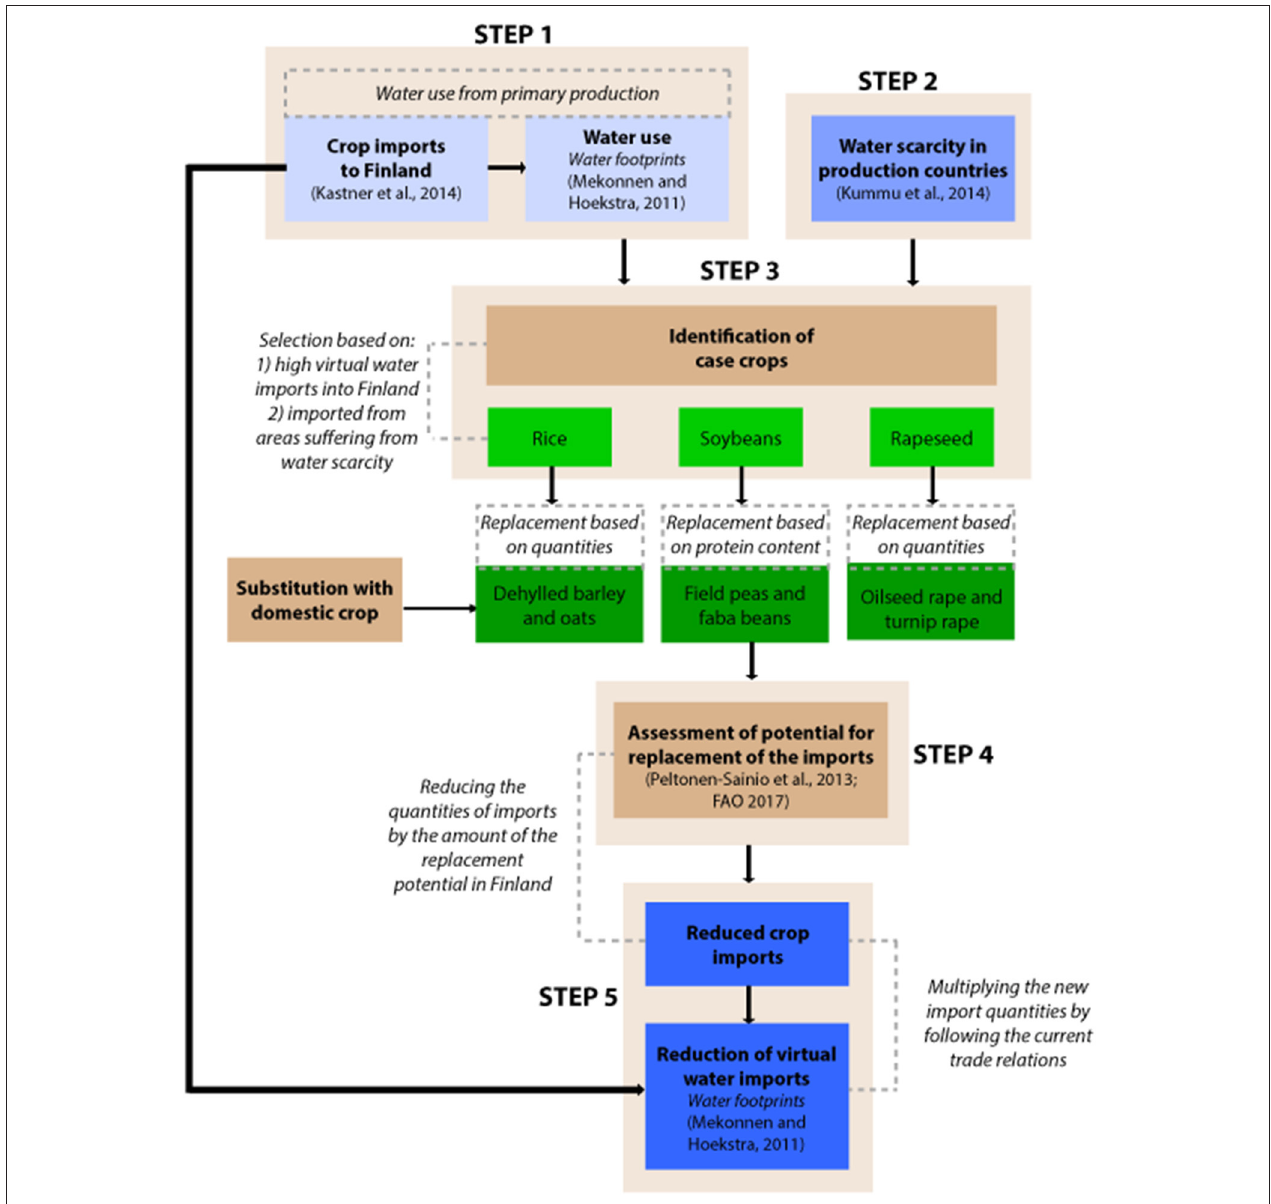
FIGURE 1 | Framework for the accounting used in this study. Principal data sources are presented in